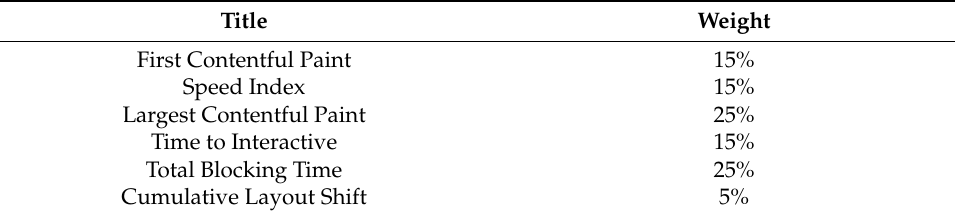
Table 5. The share of performance indicators given by